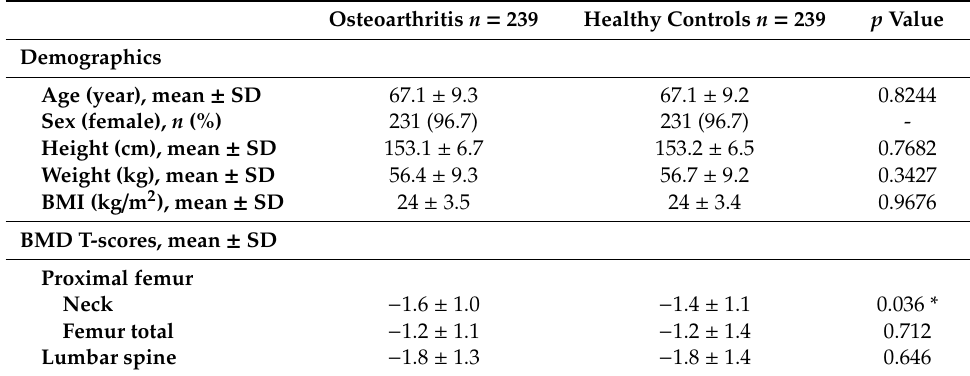
Table 1. Comparison of BMD T-scores between patients with knee osteoarthritis and healthy controls after age, sex, and BMI